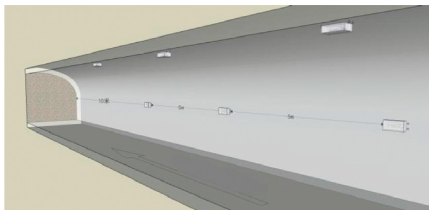
Figure 12: Roadway roof and side wall blasting vibration observation point layout diagram.